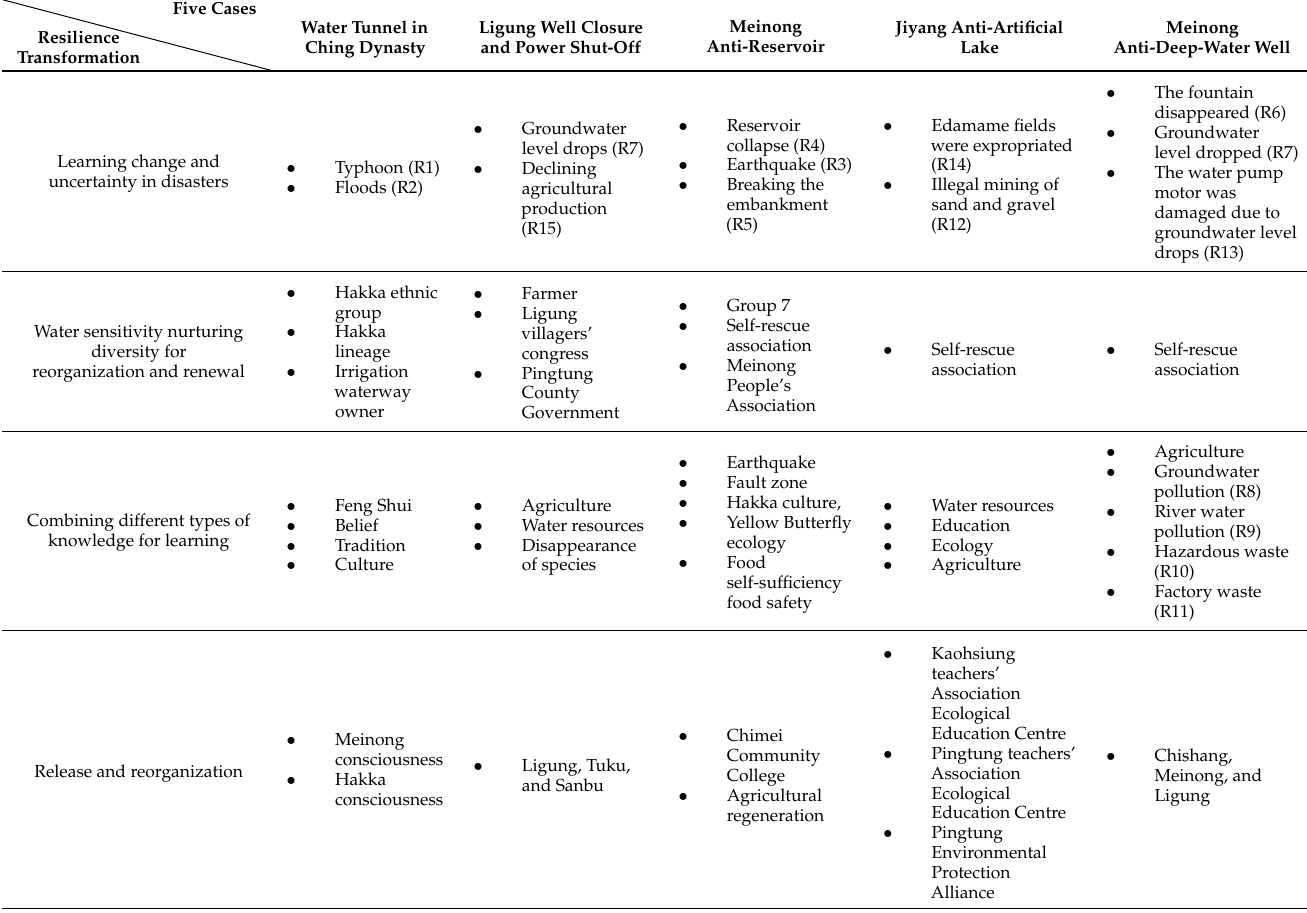
Table 3. Five cases and community